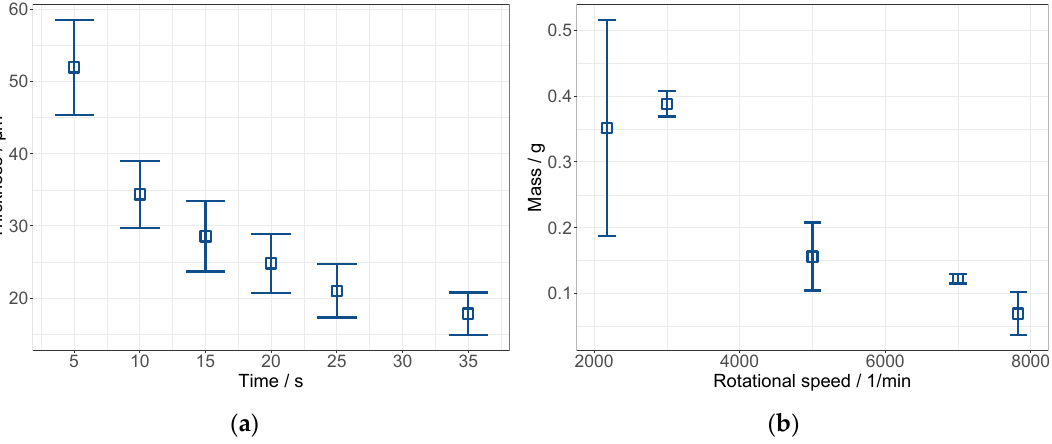
Figure 6. Wet film thickness in dependence of coating time at 4000 rpm coating speed ( a ) and wet mass ( b ) at different coating speeds and coating time of 1 min.